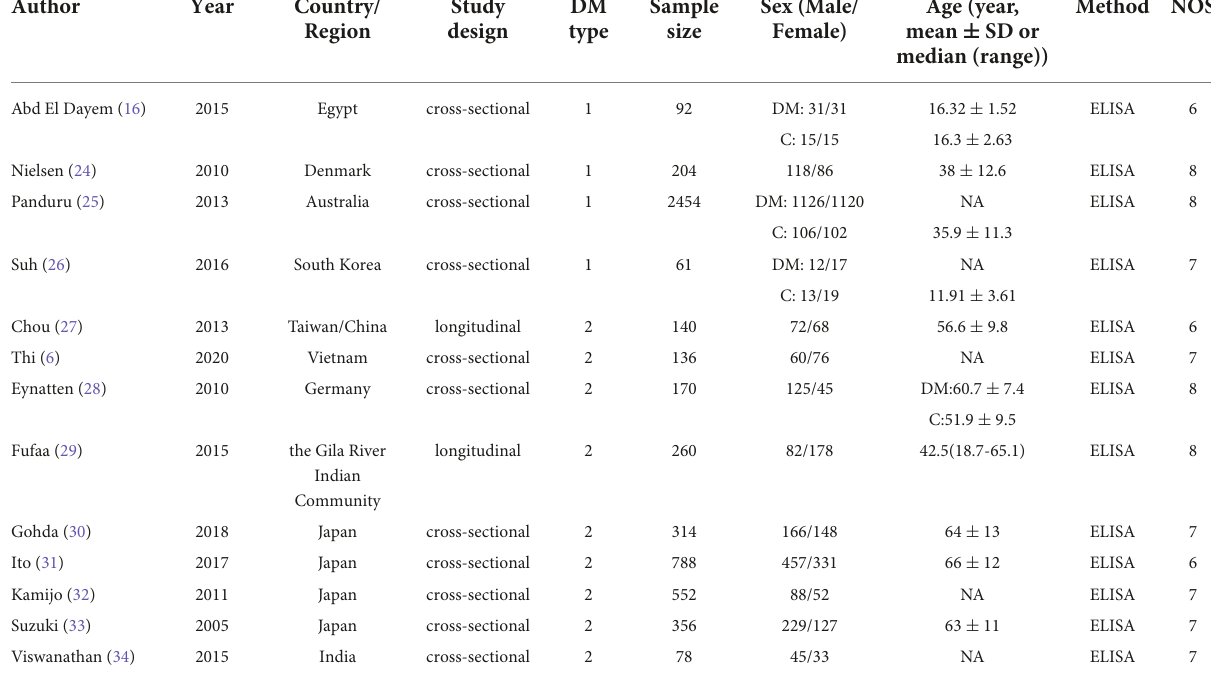
TABLE 1 Characteristics of the included